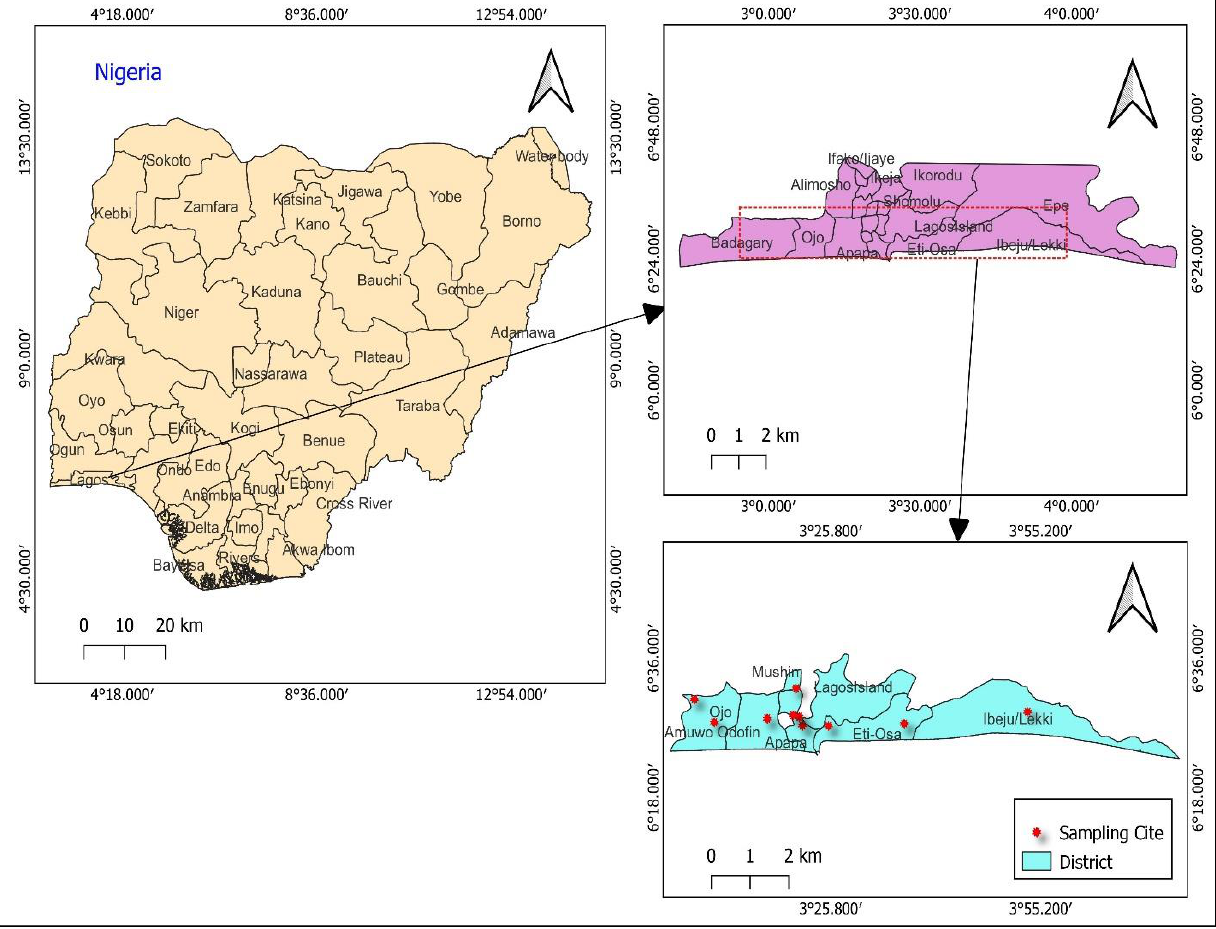
Figure 3. Map showing the geographical location of the study area.